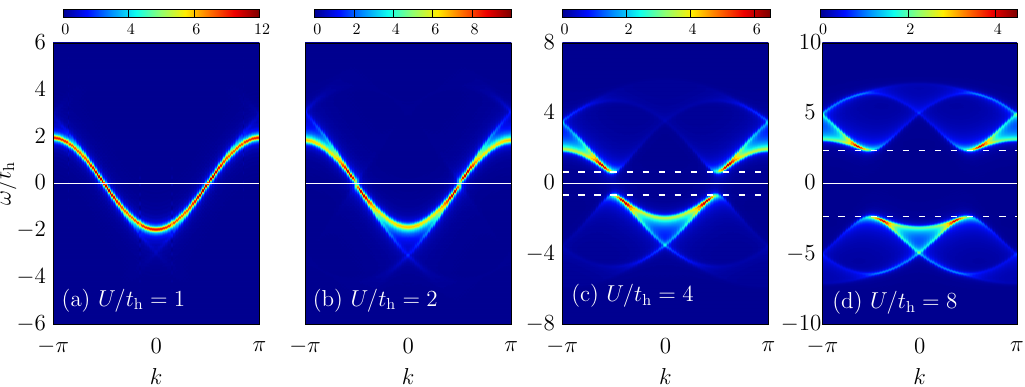
Figure 8: A ( k , ω ) in the half-filled 1D Hubbard model for various Coulomb repulsions U at T = 0. Dashed lines in (c) and (d) mark the Bethe-ansatz single-particle gap ± ∆ / c